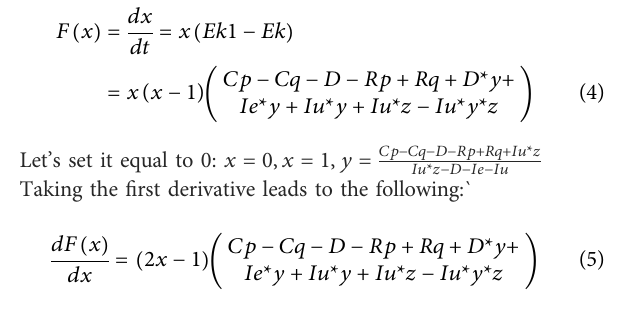
(cid:6)(cid:6)(cid:6)(cid:6) < 0, dF ( x ) x (cid:2) 0